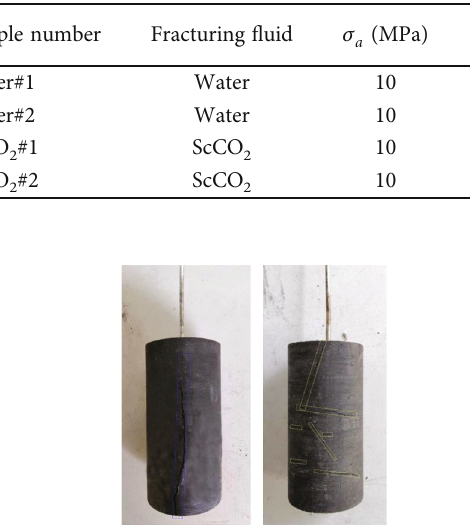
Figure 9: Crack propagation paths for the coal samples fractured by (1) water and (2) ScCO